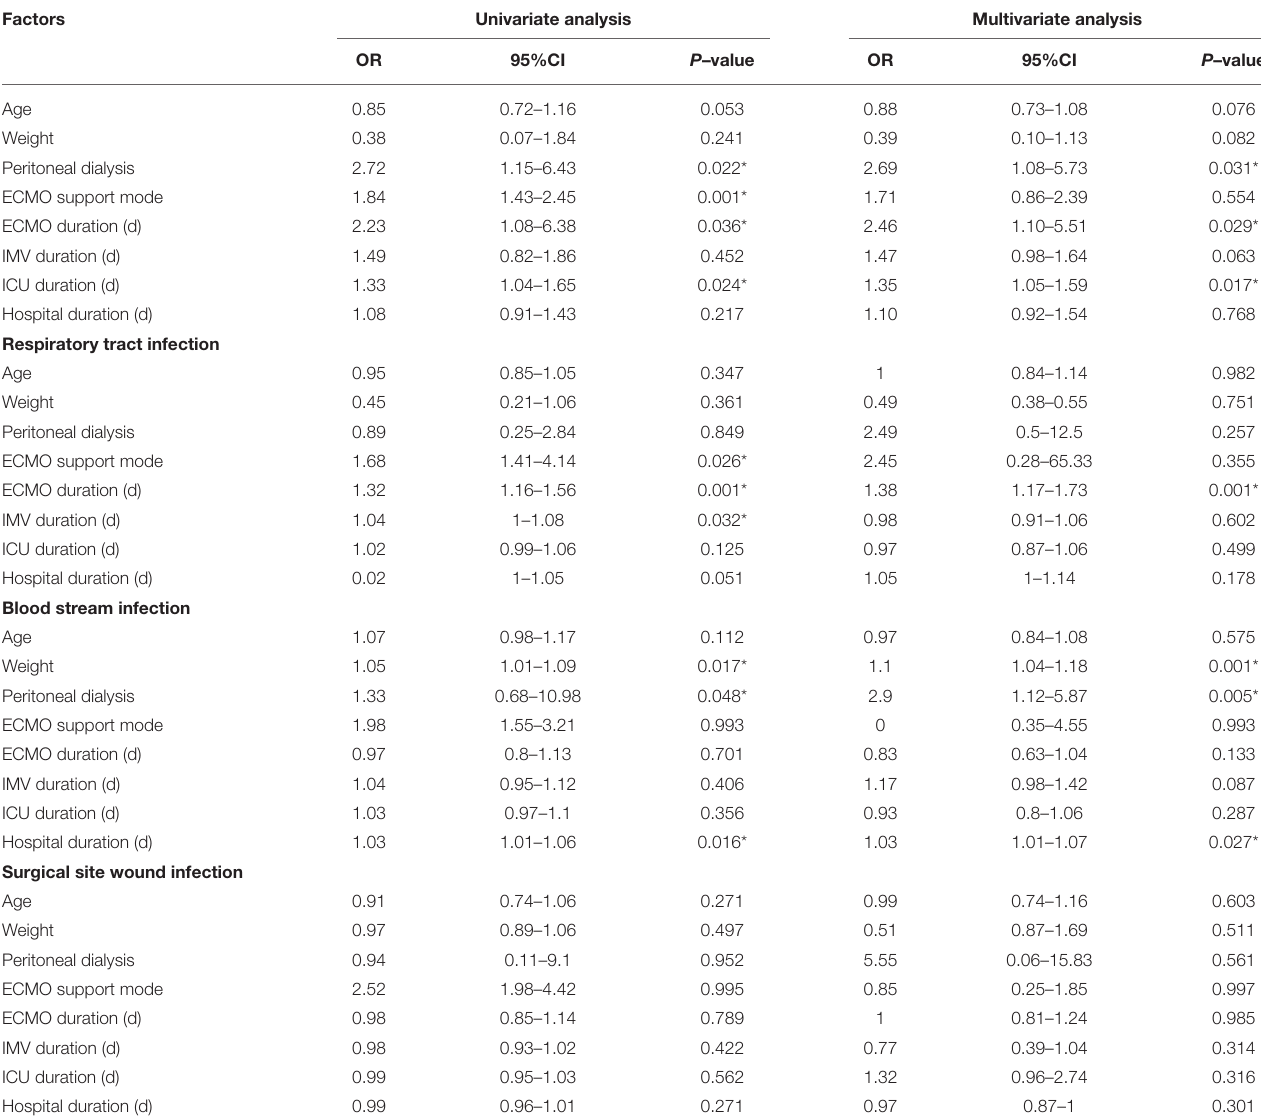
TABLE 4 | Univariate analysis and multivariate analysis of risk factors for Nosocomial infections during ECMO. Factors Univariate analysis Multivariate